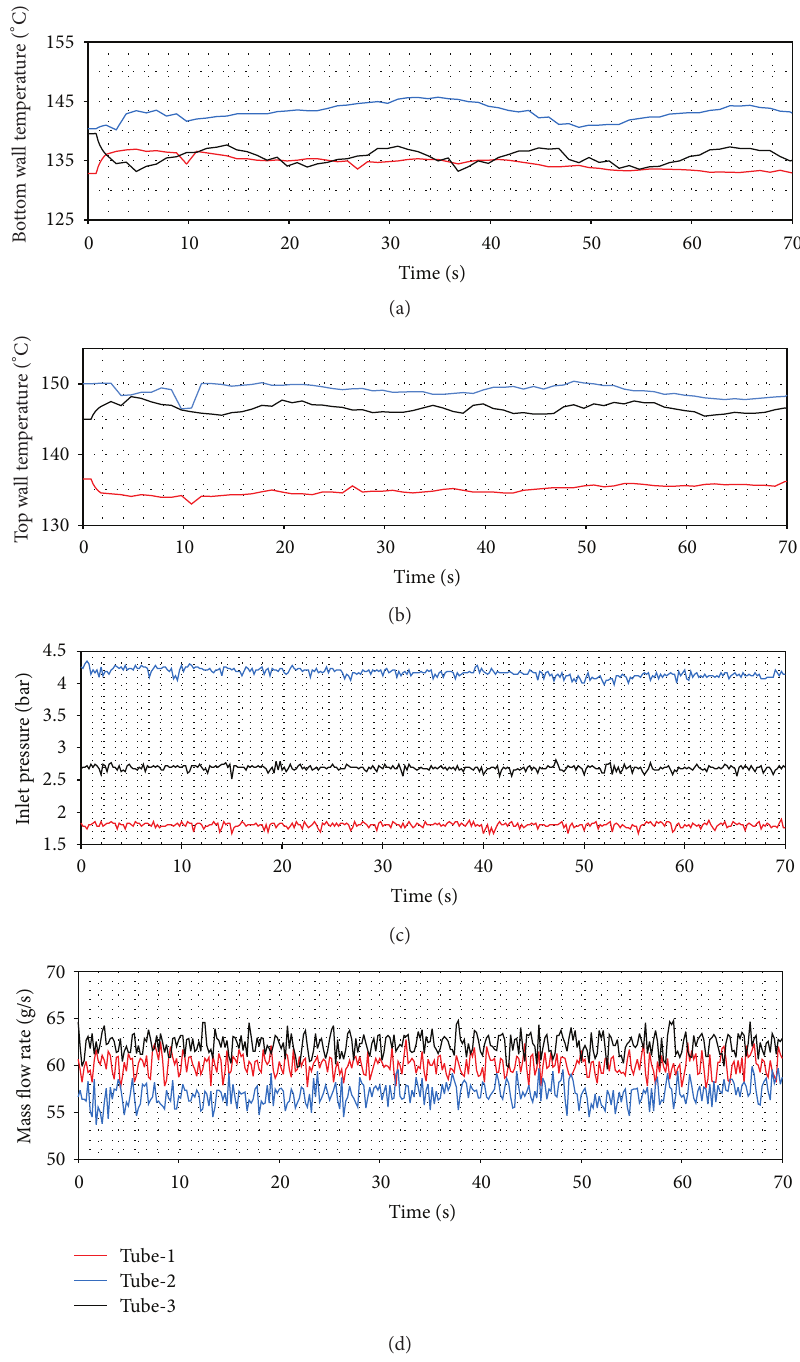
F 11: Pressure drop oscillations